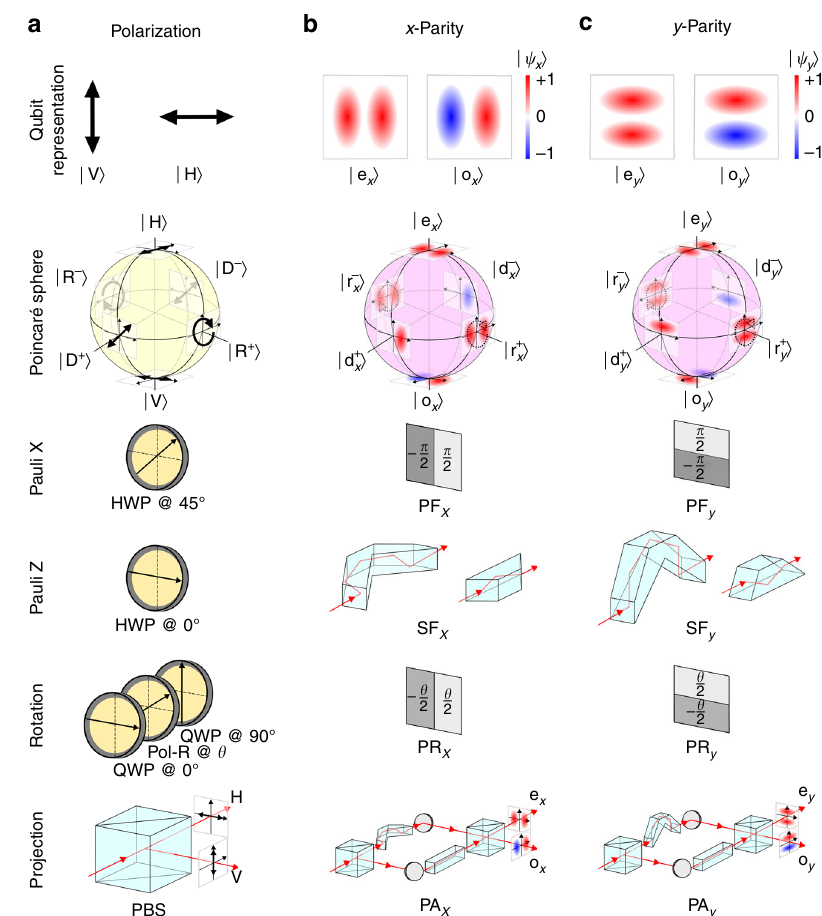
Fig. 1 Toolbox for single-photon one-qubit operations for polarization and spatial-parity. a Hilbert space of polarization showing a schematic representation of the basis, the Poincaré sphere highlighting the V j i ; H j if g , D þ j i ; D (cid:2) j if g , and R þ j i ; R (cid:2) j if g bases whose elements occupy antipodal positions;